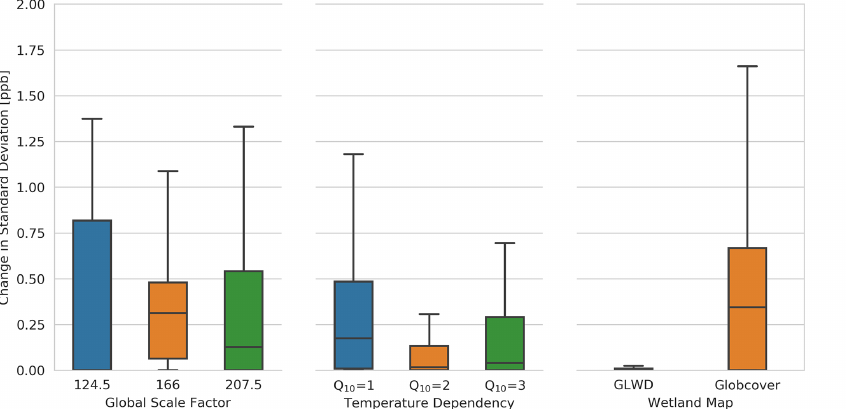
Figure 7. The change in standard deviation (ppb) between the modelled and observed wetland CH 4 seasonal cycle related to each parameter with all other parameters kept constant. The change is calculated as the difference in standard deviation from the lowest value from each set of joined ensemble members. The distribution of this change in standard deviation across all regions is illustrated using a box-and-whisker plot with the quartiles indicated by the boxed area and whiskers indicating the remaining data (excluding extreme